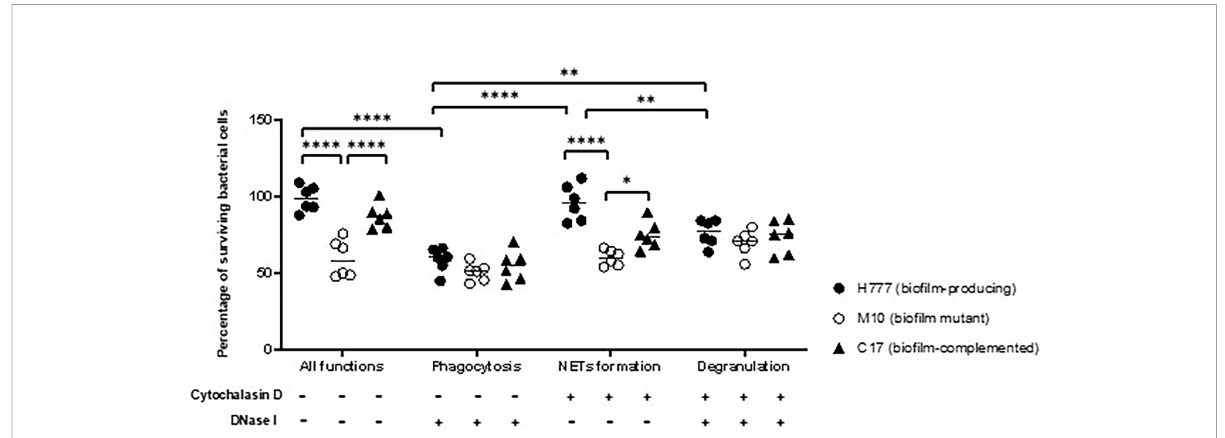
FIGURE 5 NET formation was insuf fi cient to kill B. pseudomallei cells expressing bpsl0618 . Co-cultivation of puri fi ed neutrophils and three strains of B. pseudomallei was done in the presence or absence of 10 m g/mL cytochalasin D and/or 1 unit/mL DNase I for 90 min. Percentage of cells surviving in each of the three strains of B. pseudomallei is shown in results from 3 independent experiments (n = 6). Data are represented as mean ± standard deviation. Asterisks denote statistical signi fi cance (* p < 0.05, ** p < 0.01, **** p < 0.0001).